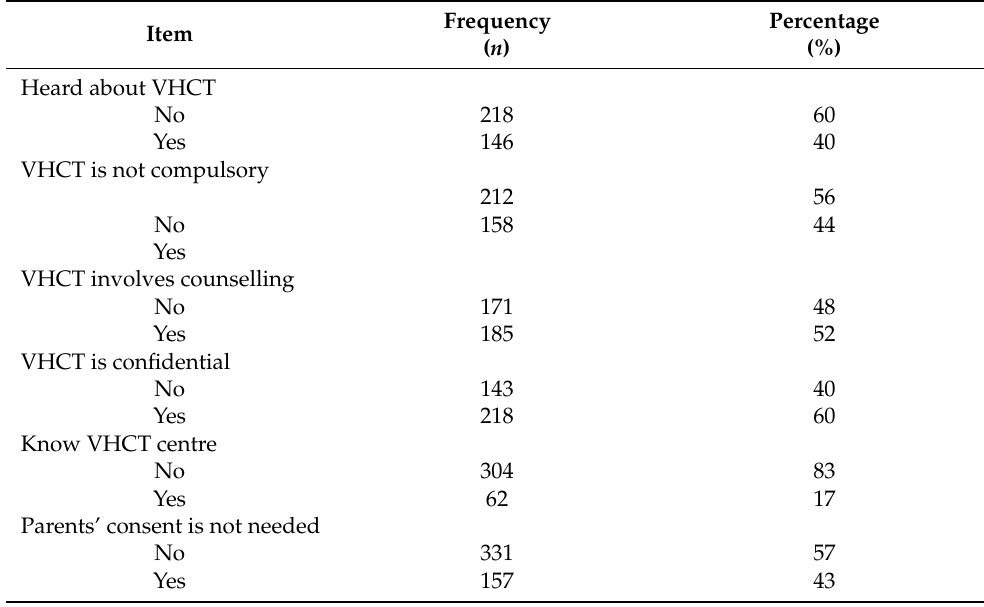
Table 2. Young people’s awareness and perceptions of VHCT.